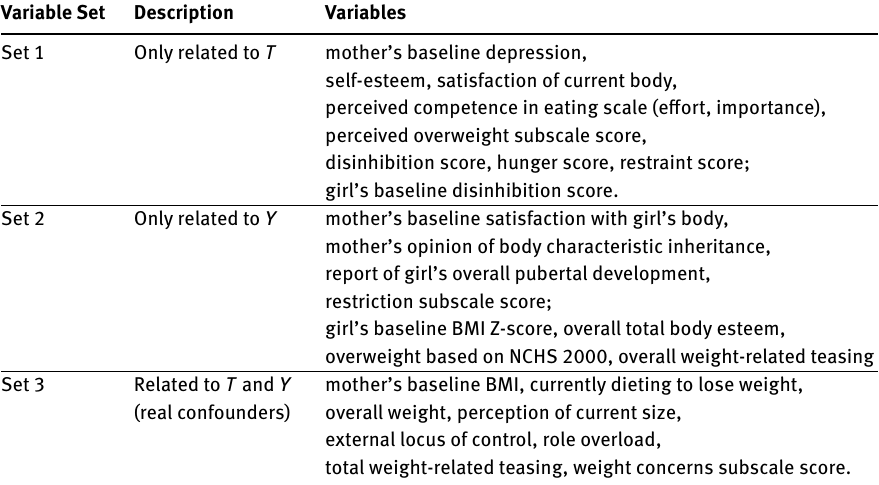
Table 6: List of variables in the Early Dieting in Girls study.